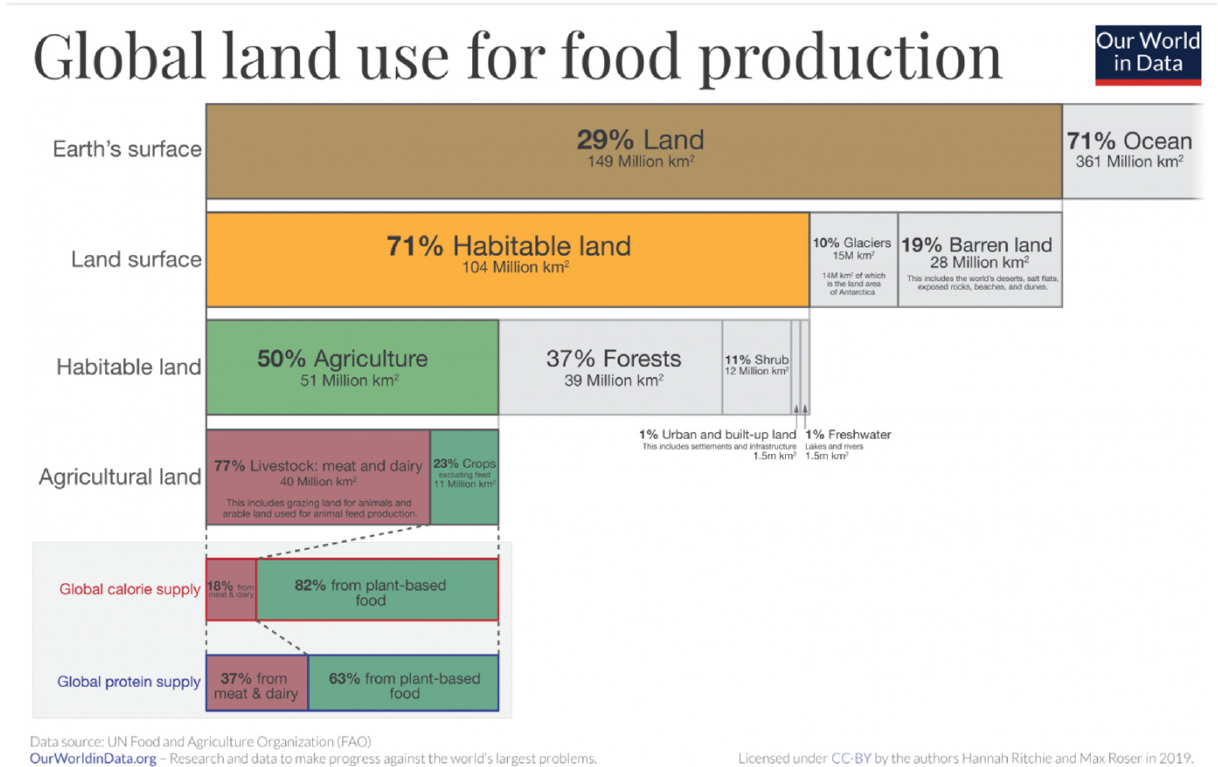
Figure 10. Global land use for food production. Adapted from Ref. [23].